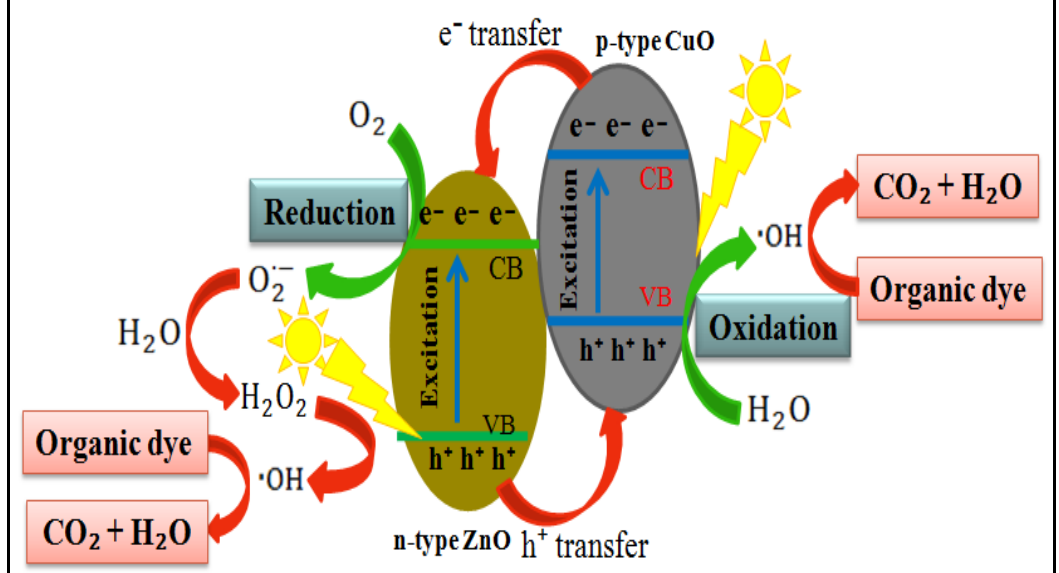
Fig.10: Mechanism of photodegradation of organic dye by ZnO/CuO hybrid nanocomposite.